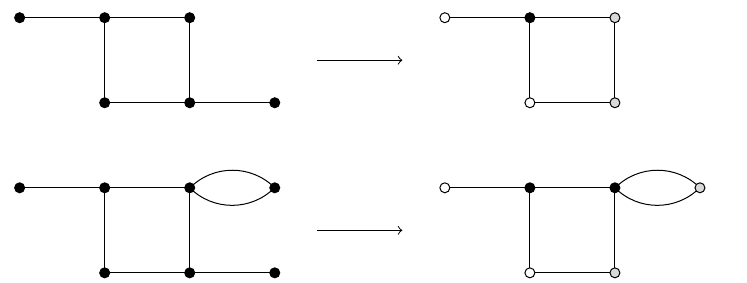
Figure 11. Transformation of frames. In transformed frames, white vertices are the left wall vertices and gray vertices are the right wall vertices of a 2-tile.